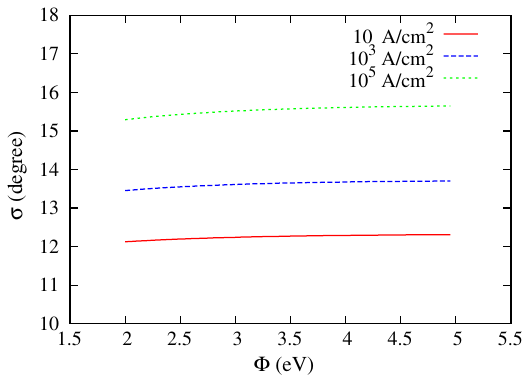
FIG. 1. Field emission from a planar copper surface. The work function of copper used here is 4.65 eV. The inset shows the relation between ln J and E .